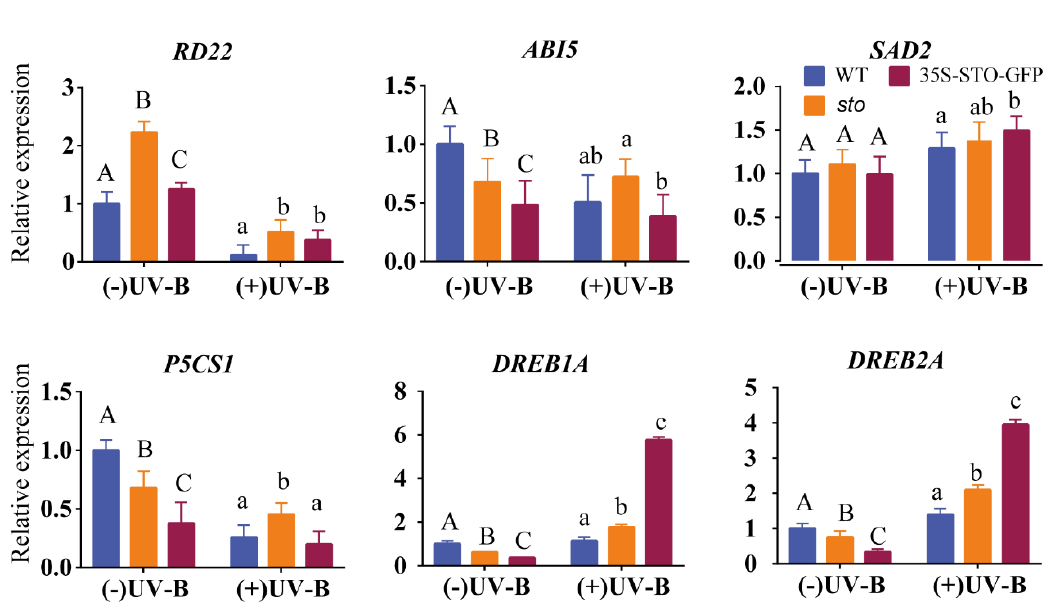
Figure 9. Expression profile of ABA pathway genes before and after UV-B treatment. The WT, sto, and 35S-STO-GFP seedlings were grown in white light for seven days and then subjected to a four-hour UV-B treatment (0.6 W/m 2 ). Error bars indicate the SEM of three independent biological and technical replicates. Di ff erent capital letters and lowercase letters indicate significant di ff erences between gene relative expression of those seedlings grown without or with UV-B radiation, respectively ( P < 0.05, Dunnett’s multiple). Actin2 was used as an internal reference